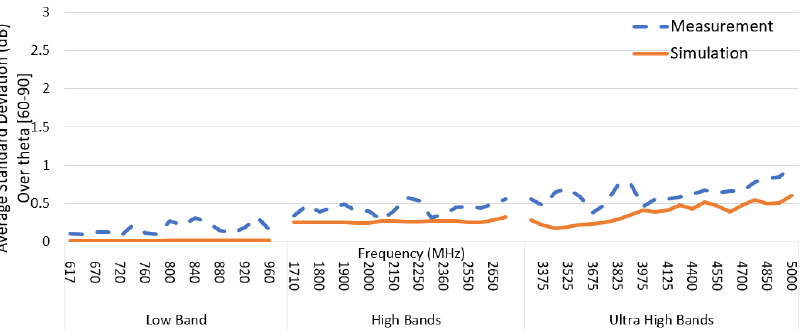
Figure 18. AUT average standard deviation for elevation zone theta (60–90 ◦ ) across the frequency range for prototype measurement and simulation data.